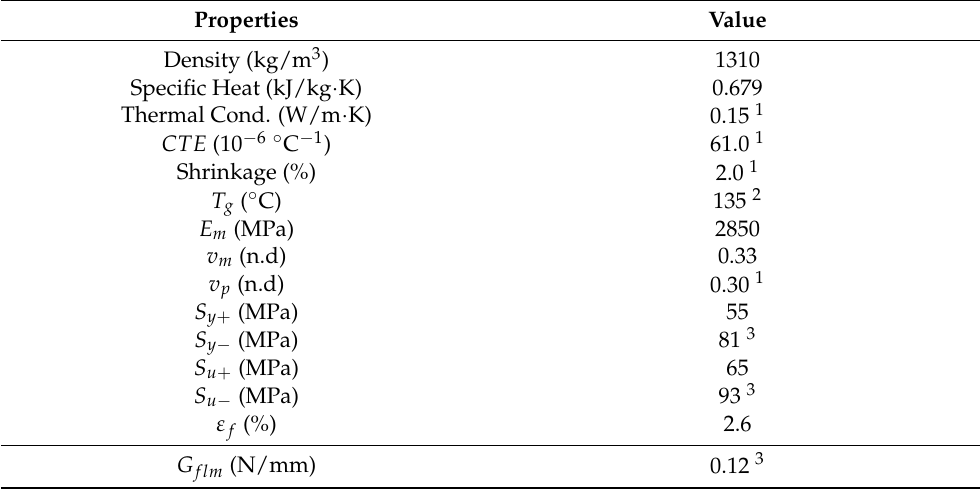
Table 2. Resin system material